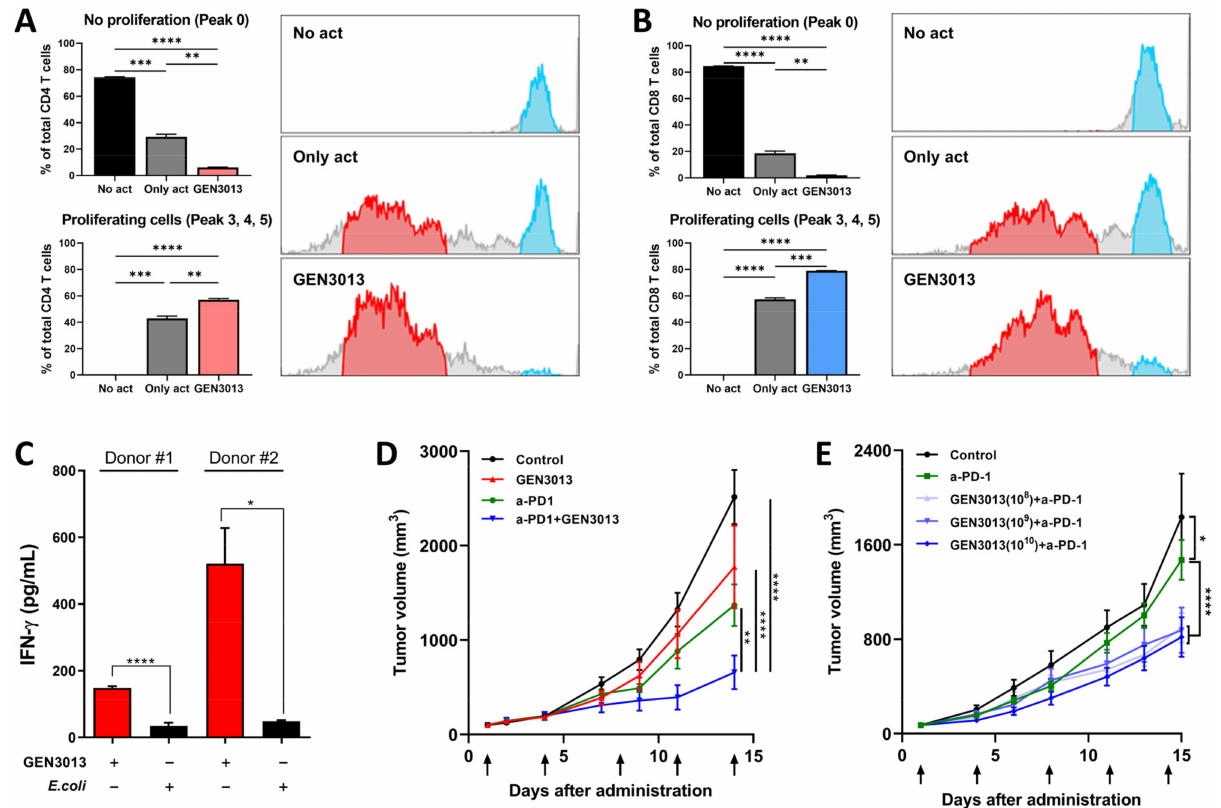
Figure 5. Lactococcus lactis GEN3013 enhances the therapeutic effects of immunotherapy. ( A , B ) Mouse T cell proliferation was measured using CFSE staining and flow cytometry. Blue population (right panel) represents no proliferative cells (peak 0), while the red population indicates actively proliferative cells (peaks 3, 4, and 5). The p -values for the peak 0 population in CD4 + T cells ( p = 0.0002, p ≤ 0.0001, p = 0.0019), the peak 3, 4, and 5 populations in CD4 + T cells ( p =